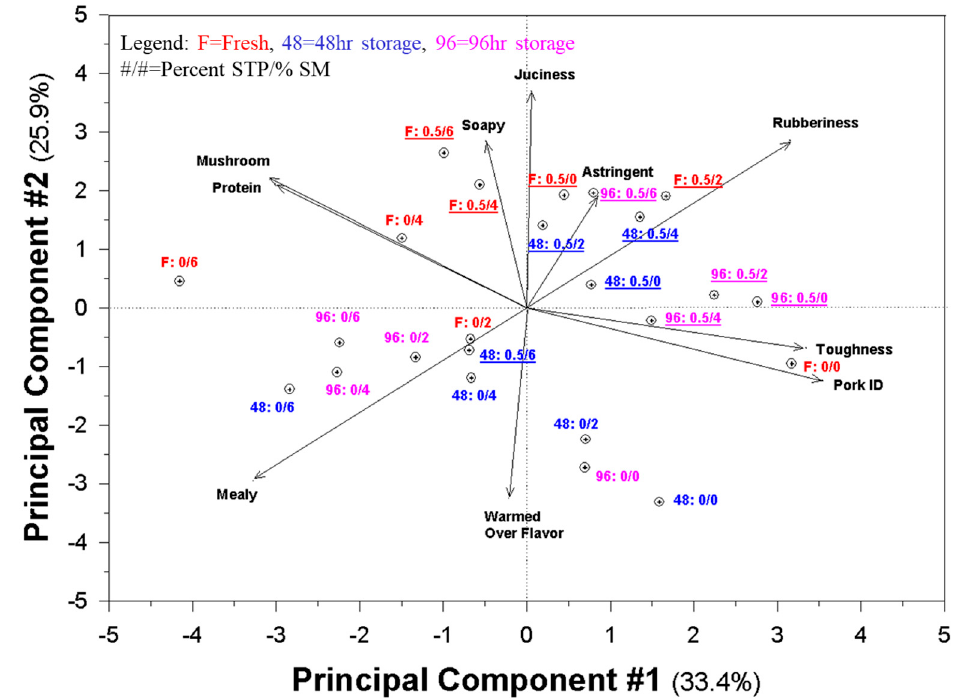
Figure 1. Principal component analysis (PCA) plot relating samples varying in amount of shitake mushroom powder and sodium tripolyphosphate to attribute intensities given by the descriptive panel.